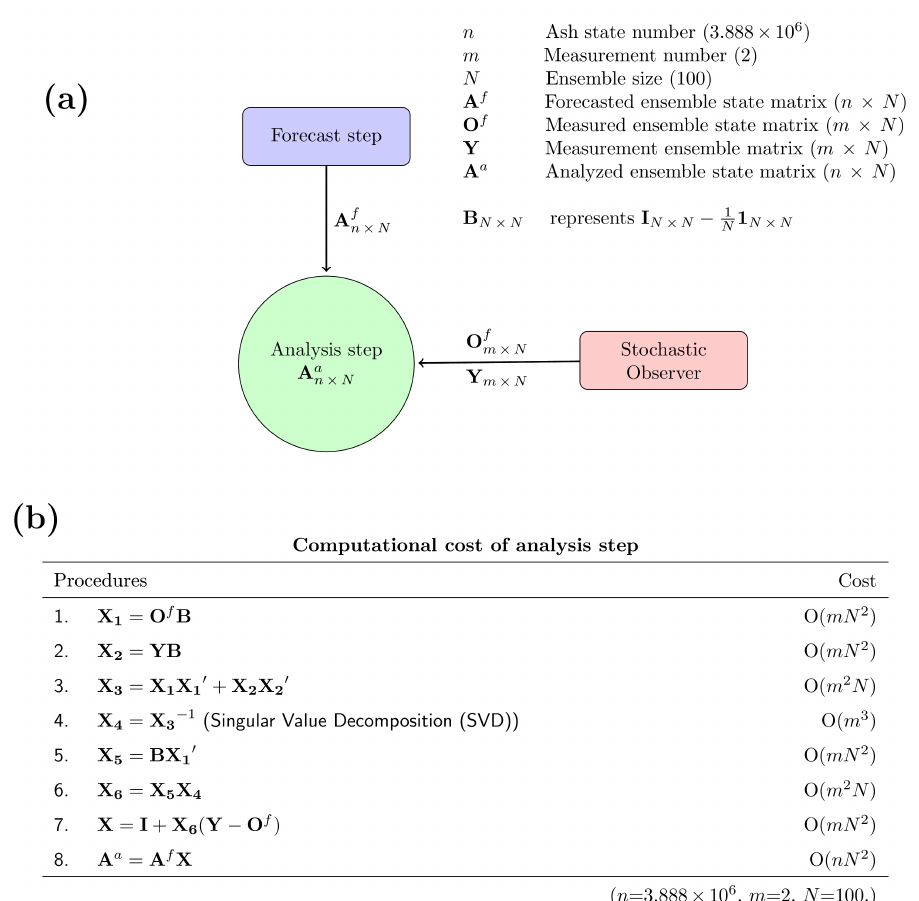
Figure 2. Computational evaluation of the analysis step. (a) Illustration of the analysis step. (b) Computational cost of all sub-parts of the analysis